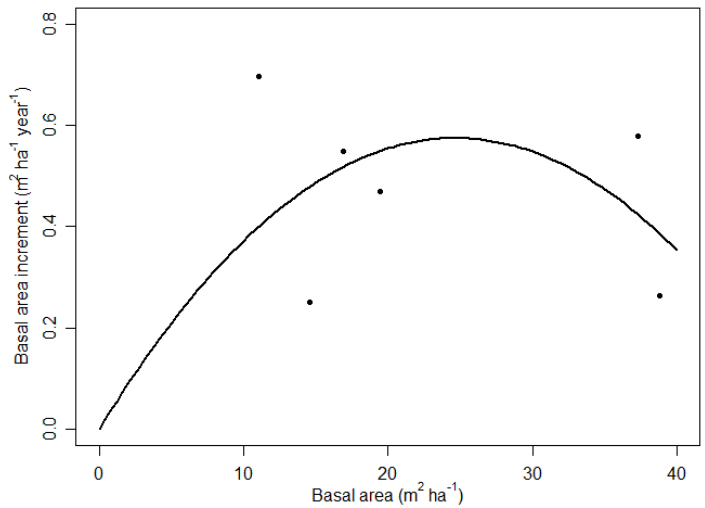
Figure 5. Relationship between basal area and basal area increment for oak ‐ hornbeam stands with different stocking (3 sites × 2 remeasurements). Dots with basal area of about 38 m 2 ha − 1 are un ‐ thinned. We added a second ‐ order polynomial function forced through the plot origin to illustrate the plateau effect of stocking and increment [11]